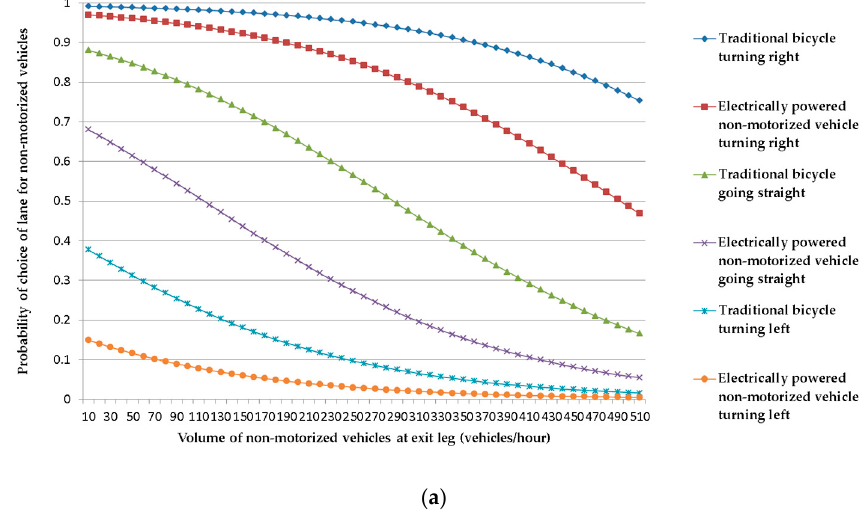
Figure 4. Probability curves of lane choice of male riders of non-motorized vehicles. ( a ): Width of lane for non-motorized vehicles being 1.5 m; ( b ): width of lane for non-motorized vehicles being 3.75 m.